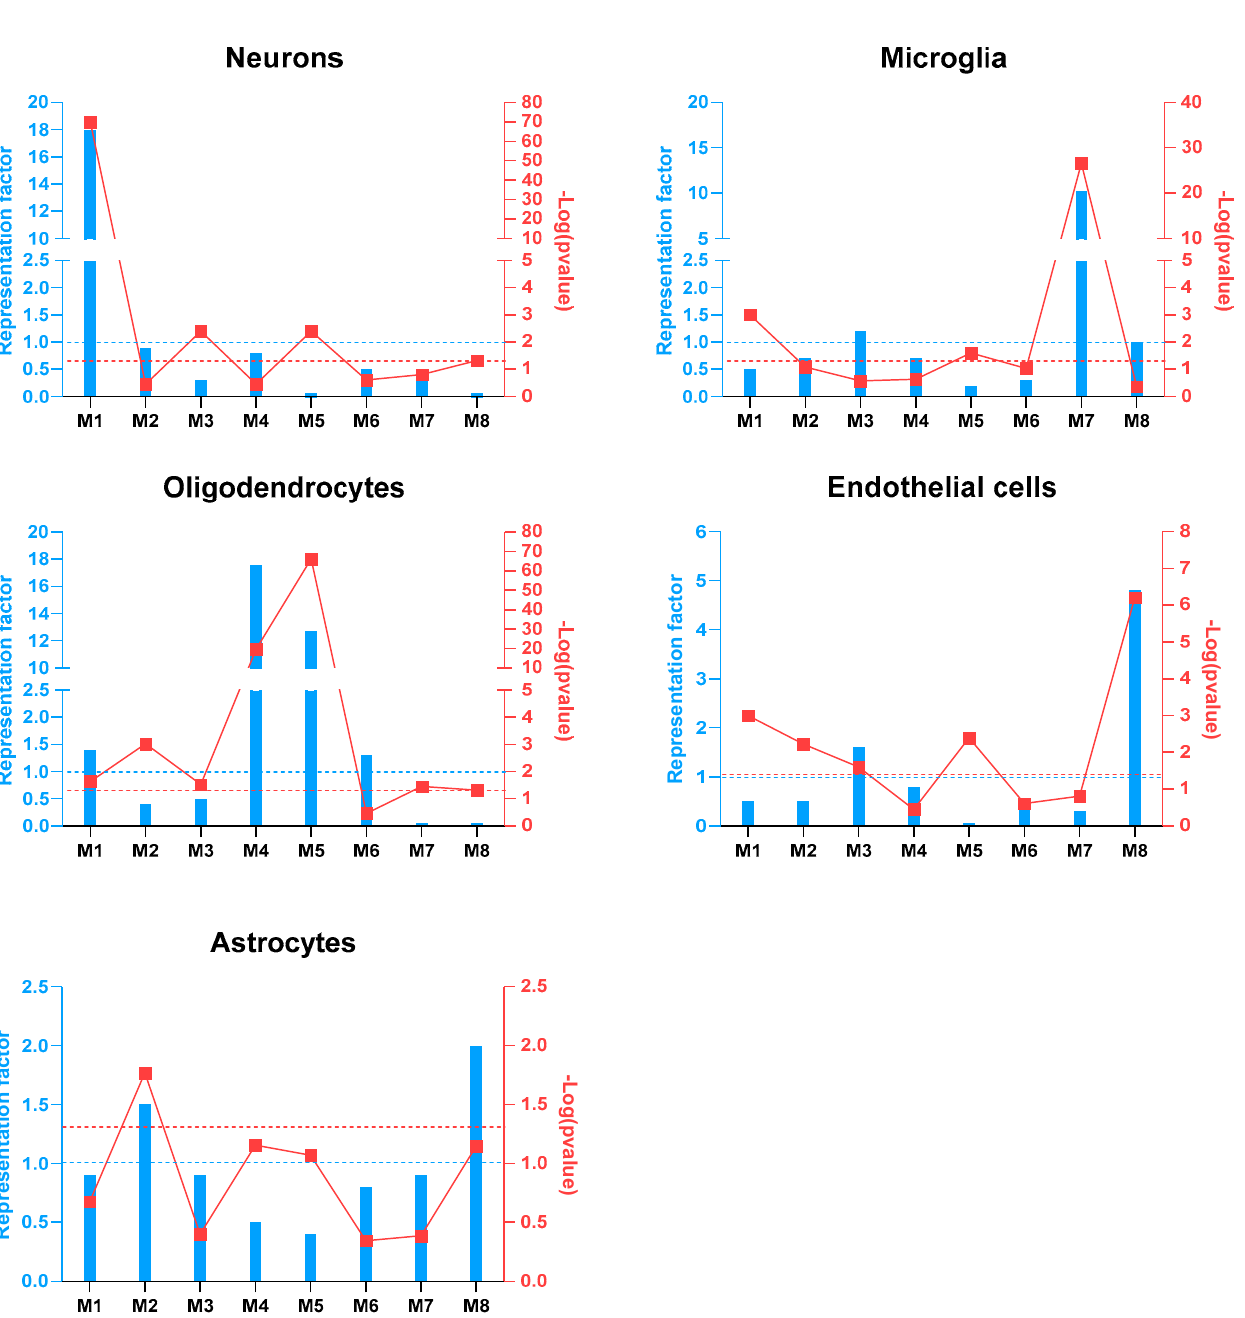
Figure 3. Gene co-expression network modular analysis. Over-representation analysis for the brain cell populations in each of the modules identified in the co-expression network modular analysis of the GSE35864 dataset. Table 2. Results for the gene co-expression network modular analysis performed on the GSE35864 dataset.